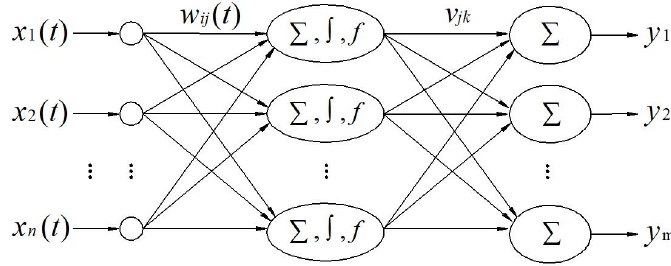
Figure 5. The CPPNN model.